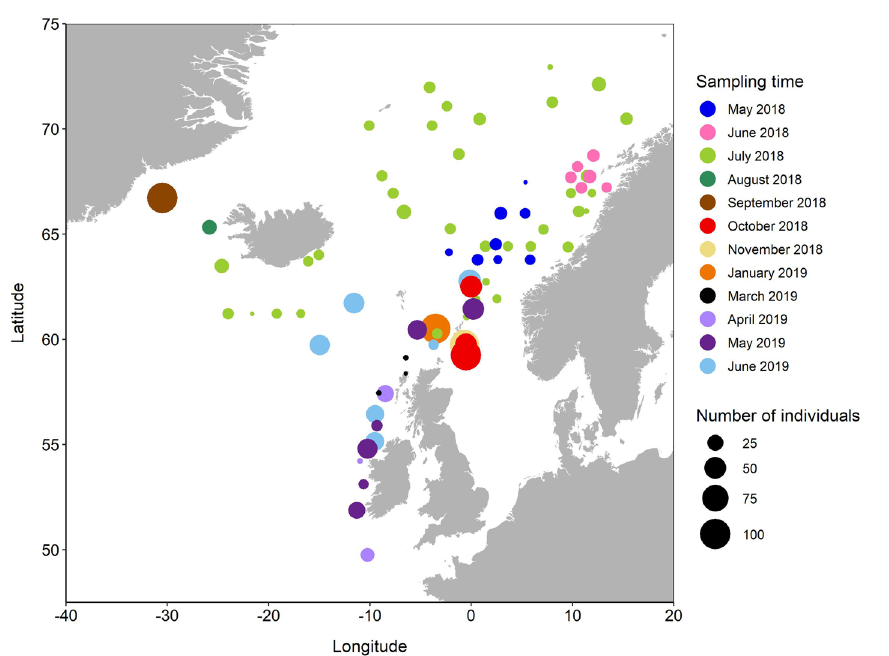
Figure 2. Map with location and number of all mackerel female samples collected from May 2018 to June 2019. The map was created using R v4.0.4 (https:// www.r- proje ct. org/) (see details at “Material and methods”